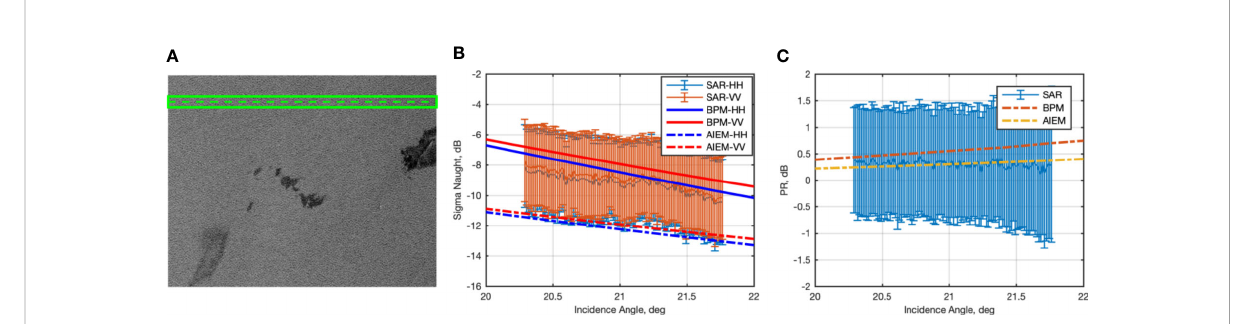
FIGURE 4 Experiments related to the TSX SAR scene acquired on June 8, 2011, at low incidence angle (about 21°), see Table 1. (A) Excerpt of the HH- polarized speckle- fi ltered SAR scene. From the leftmost part of the image to the rightmost one, plant, emulsion and crude oil slicks can be observed. The image also includes a ROI, marked in green color, used to analyze the reference sea surface backscattering. (B) Mean and standard deviation values (errorbars) of the HH- and VV-polarized NRCSs measured within the slick-free ROI, together with the NRCSs